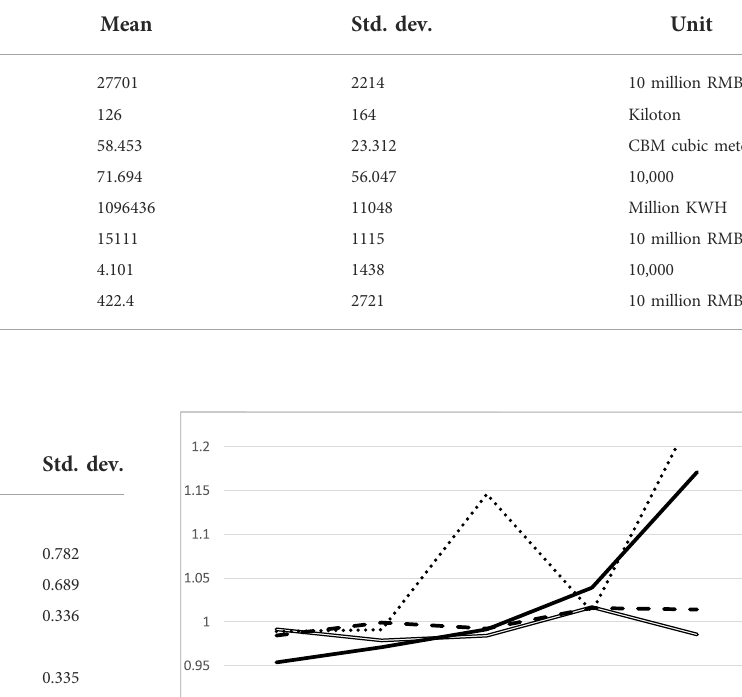
TABLE 1 De fi nition of variables and the descriptive statistics.